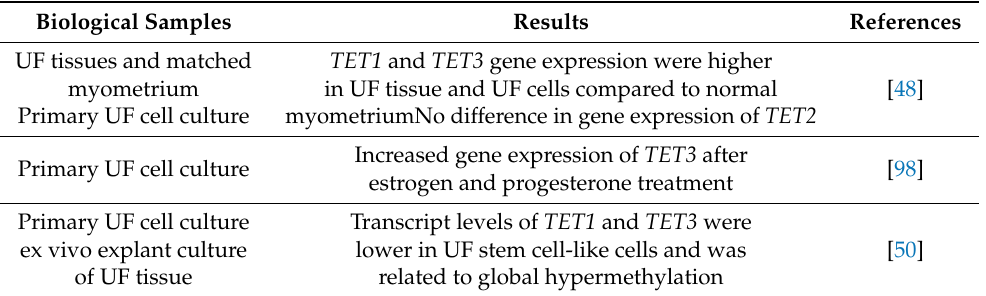
Table 1. Overview of the TET-related studies in